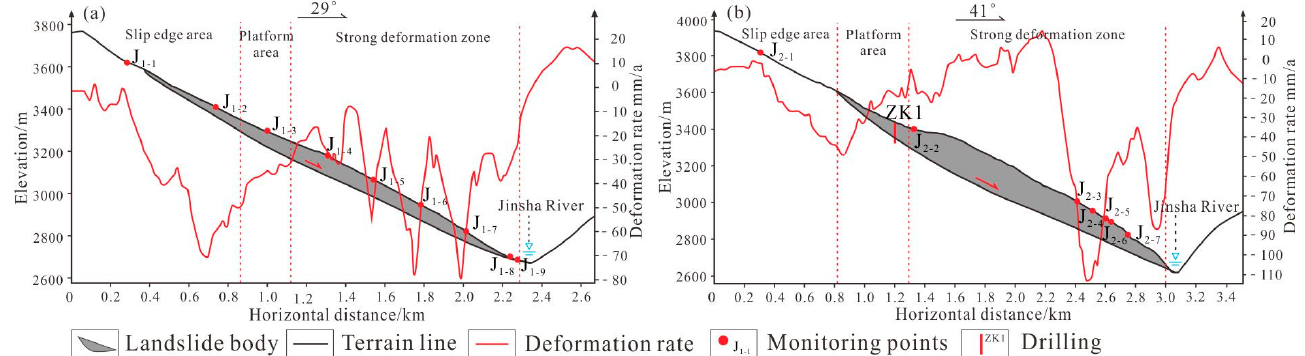
Figure 8. Map of InSAR deformation characteristics of the Xiongba landslide.